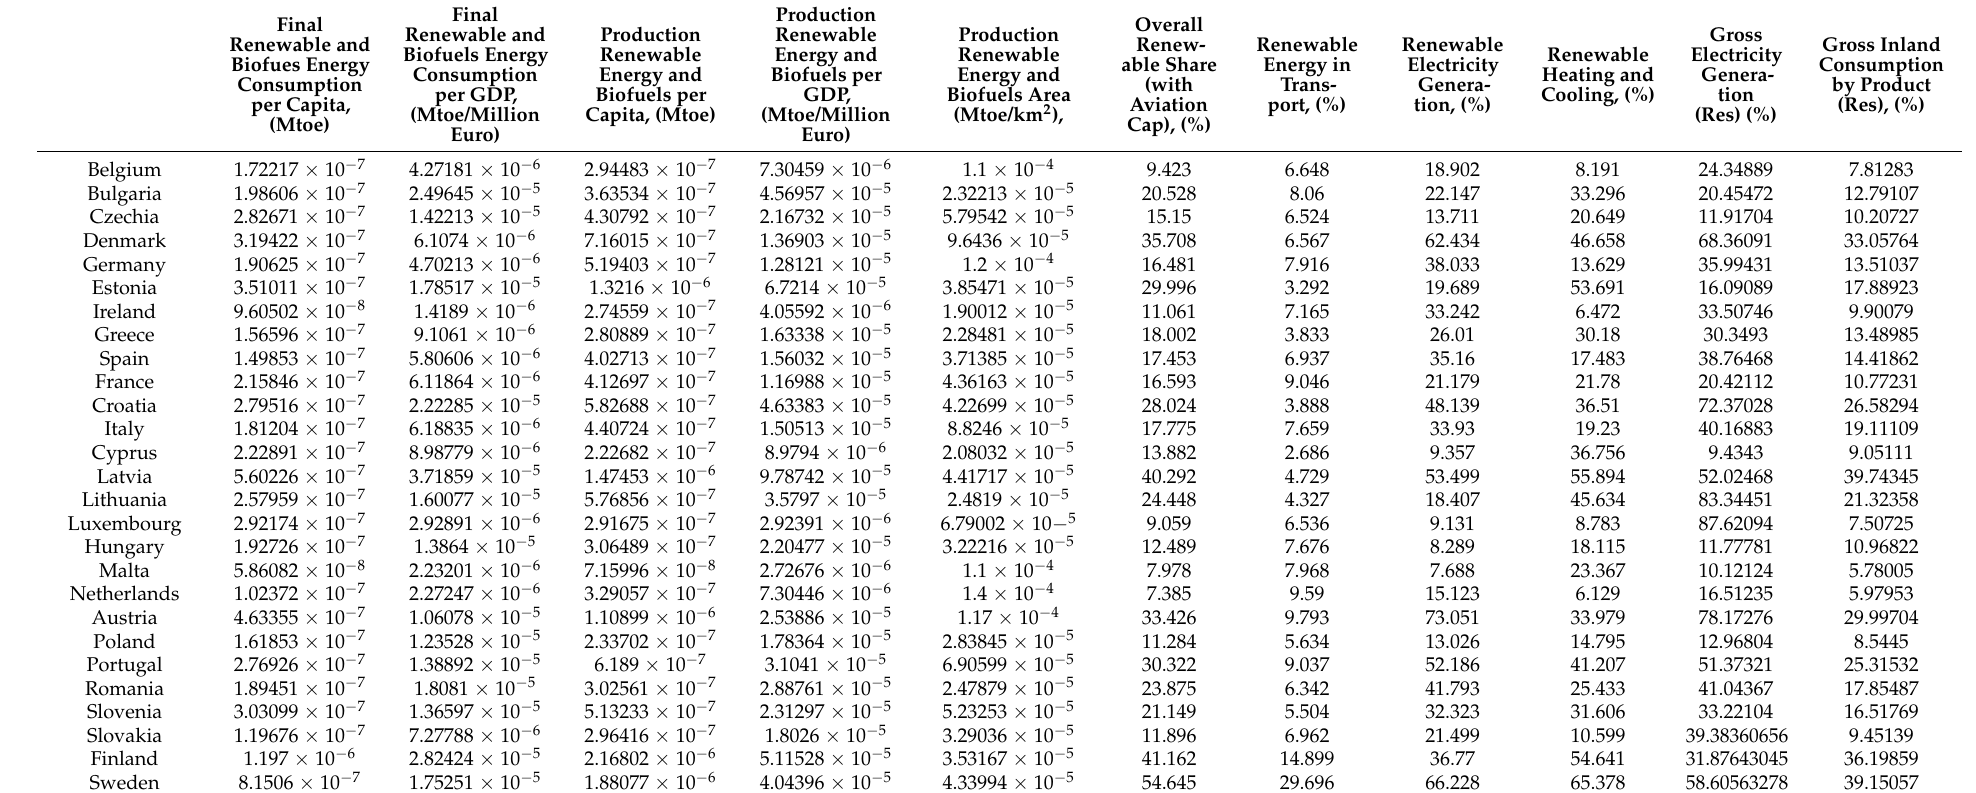
Table A3. Values Renewable energy indicators in 2018 (own elaboration based on